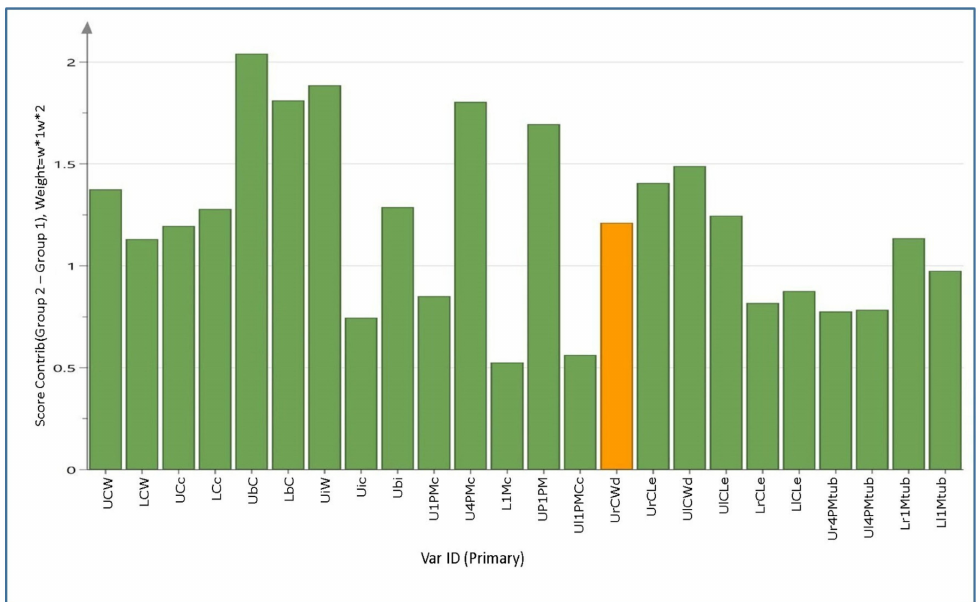
Figure 8. Contribution variables for the sex di ff erentiation. Contribution plot indicating the most significant variables in di ff erentiating males from females with the strongest mean di ff erences ( p < 0.05). Since the data was a scaled unit vector, the vertical scale units were presented in terms of standard deviations (SDs). The dominant bars show which variables deviate most from the reference point (in this case, the average). The orange colour shows which variables lie outside the 3 SD range, i.e., that which is most